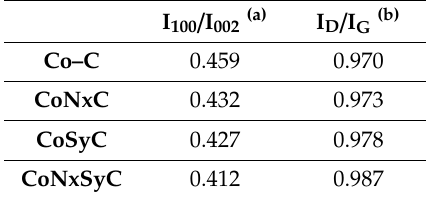
Figure 3. X-ray di ff raction patterns of various co-catalysts. Figure 3. X-ray diffraction patterns of various co-catalysts. Table 1. Relative intensity ratios of plane (100) / (002) and D / G Table 1. Relative intensity ratios of plane (100)/(002) and D/G band.